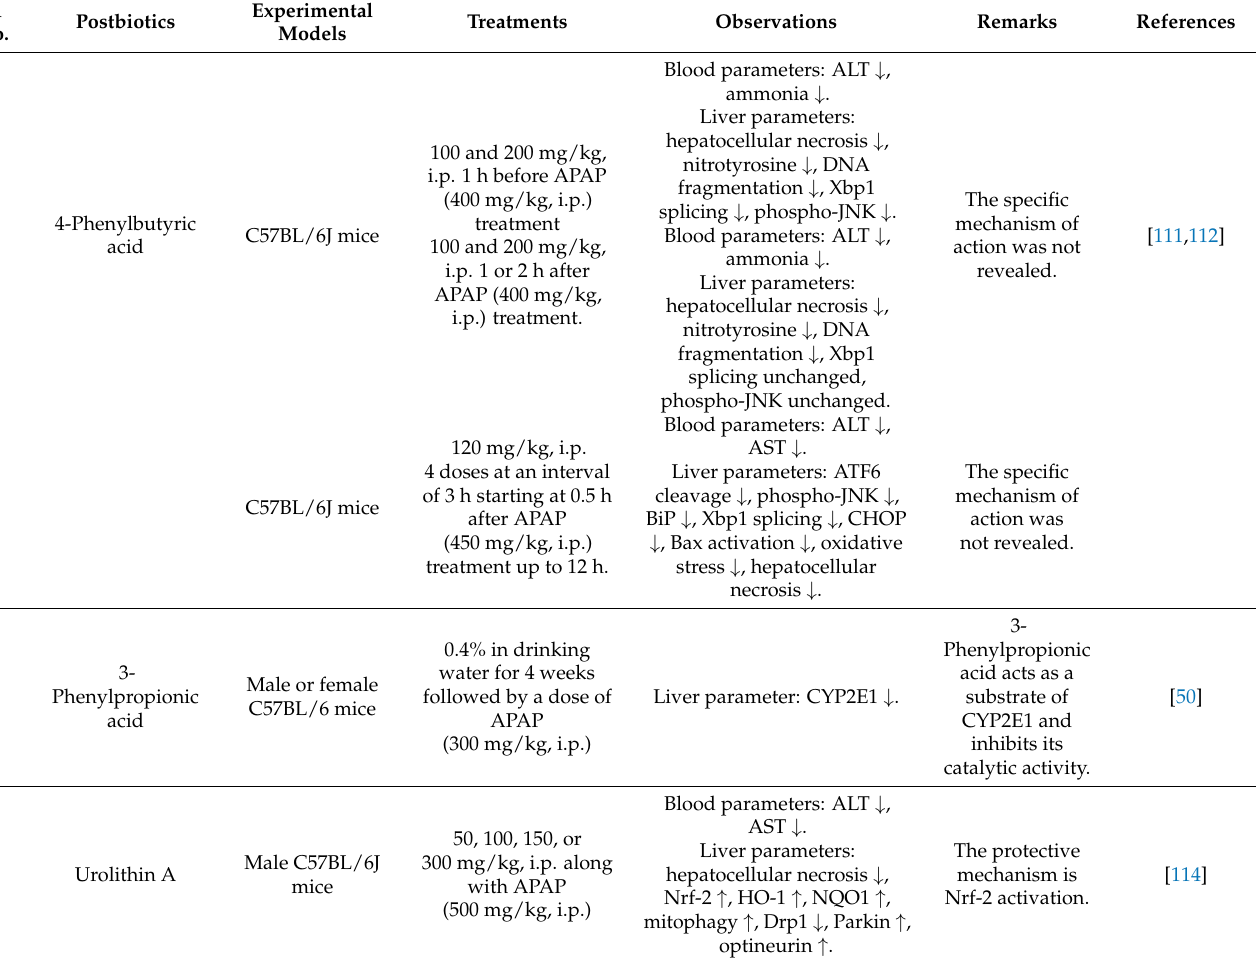
Table 3. A summary table representing hepatoprotective roles of postbiotics against APAP hepatotoxicity. Sl